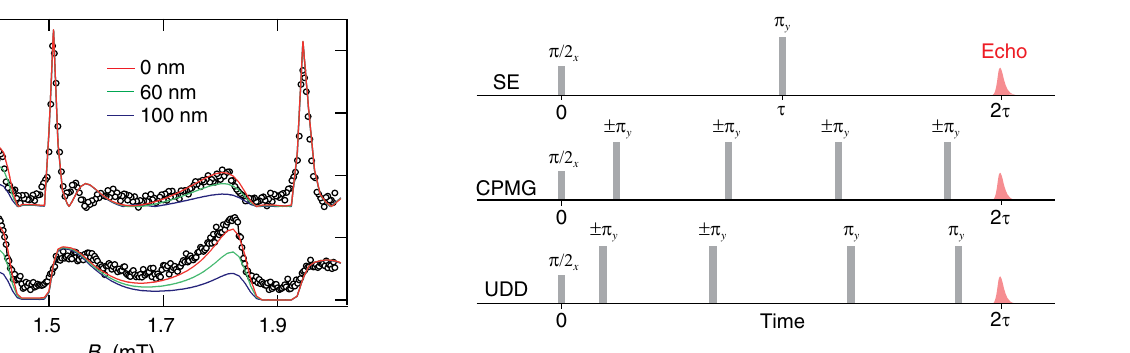
FIG. 10. Pulse sequences for spin echo, CPMG, and UDD ( N ¼ 4 ). Phase cycling is done by controlling the sign of the π pulses. Subscripts x , y denote the axis of the